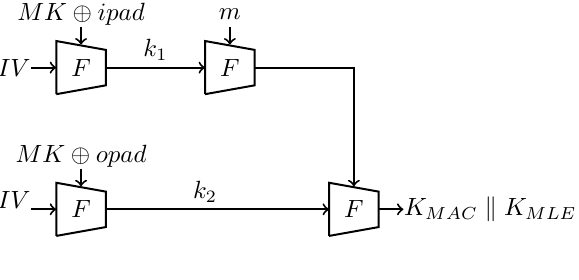
Figure 2: Key generation using HMAC.